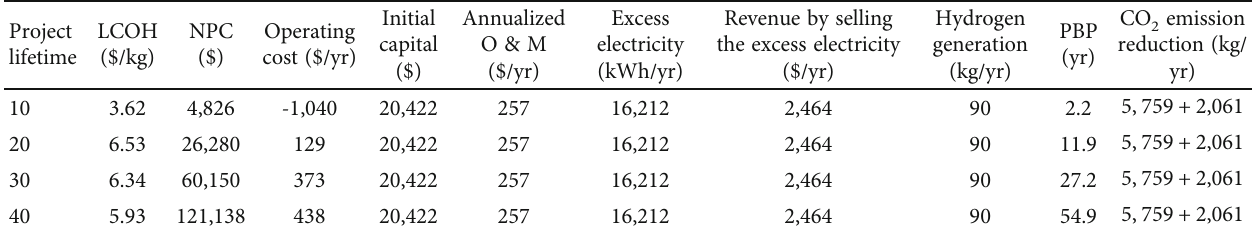
Table 7: Technical and economic analysis of the proposed system under scenario 2.